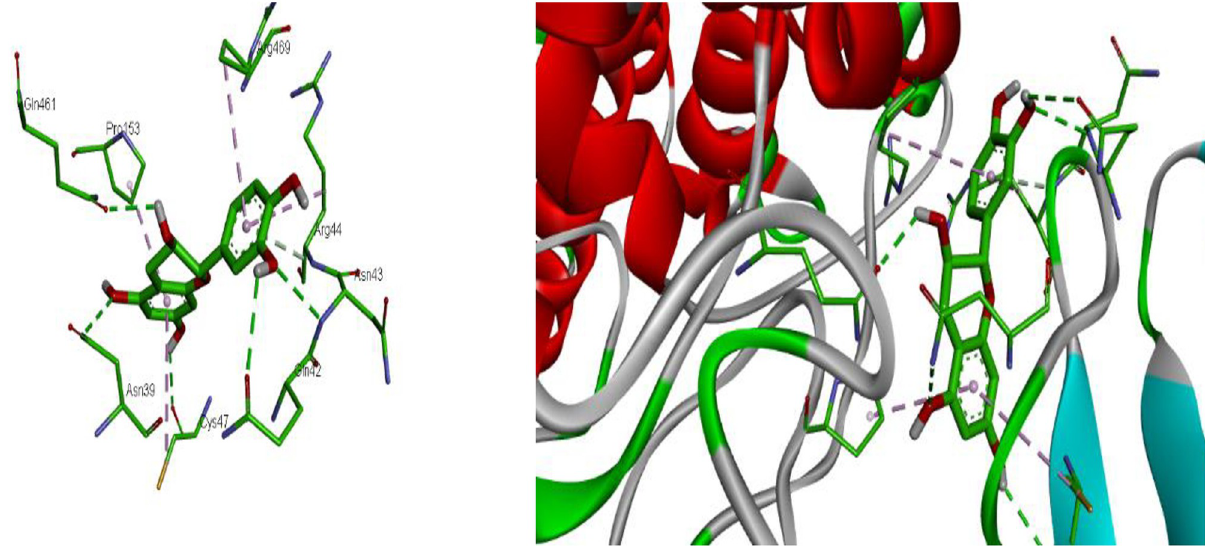
Fig 9. 2D and 3D representations of the interaction of catechin with COX-2 (PDB ID: 1CVU). https://doi.org/10.6084/m9.figshare.21828963.v1.